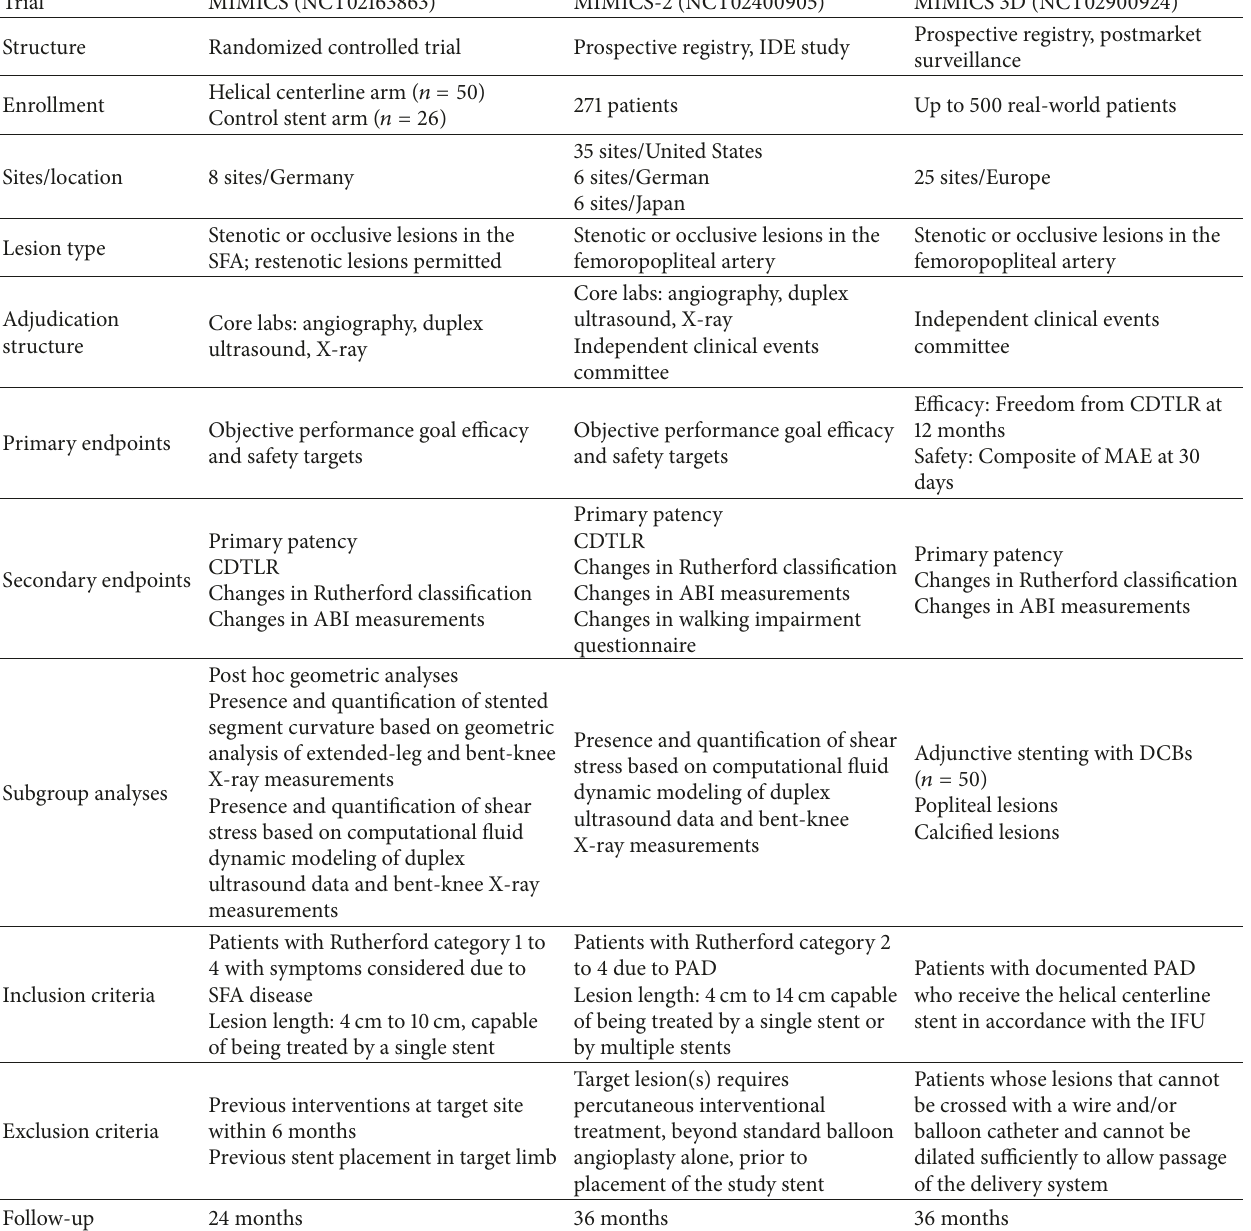
Table 1: The MIMICS Clinical Trial